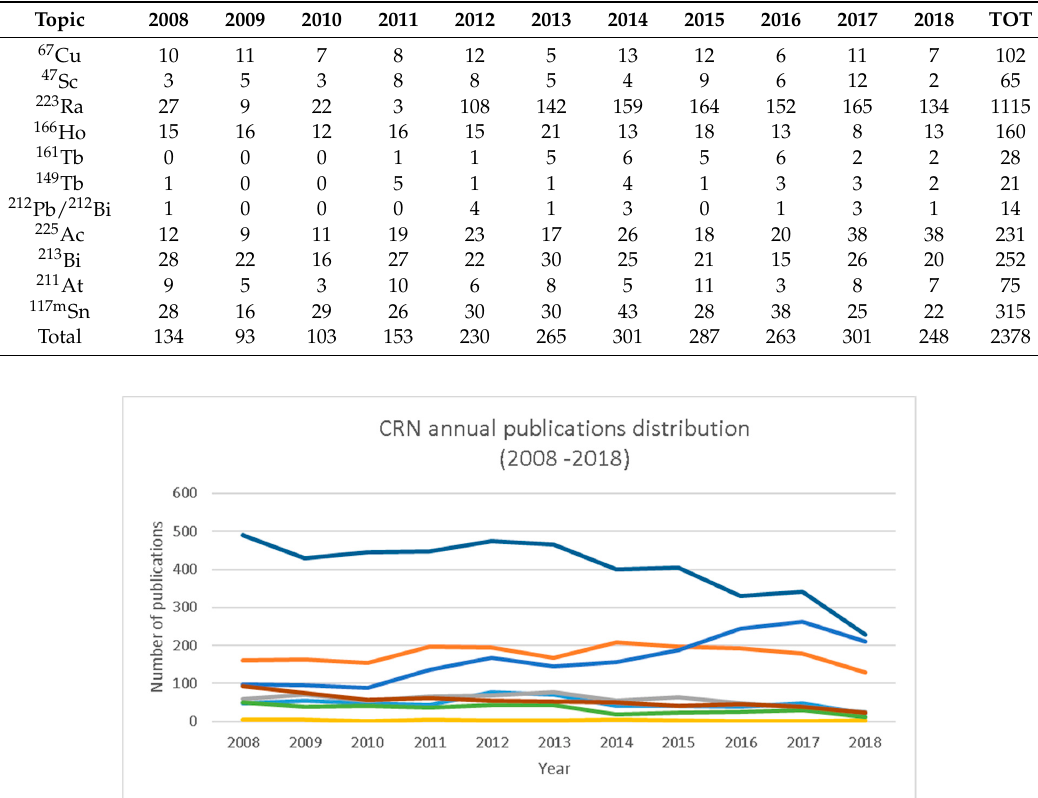
Figure 1. A comparison between the annual publication number of CRNs vs. ERNs (2008–2018). Total number of papers = 12717; total number of papers on CRNs = 10339; total number of papers on ERNs Table 7. Annual publications discussing ERNs (2008–2018). = 2378.